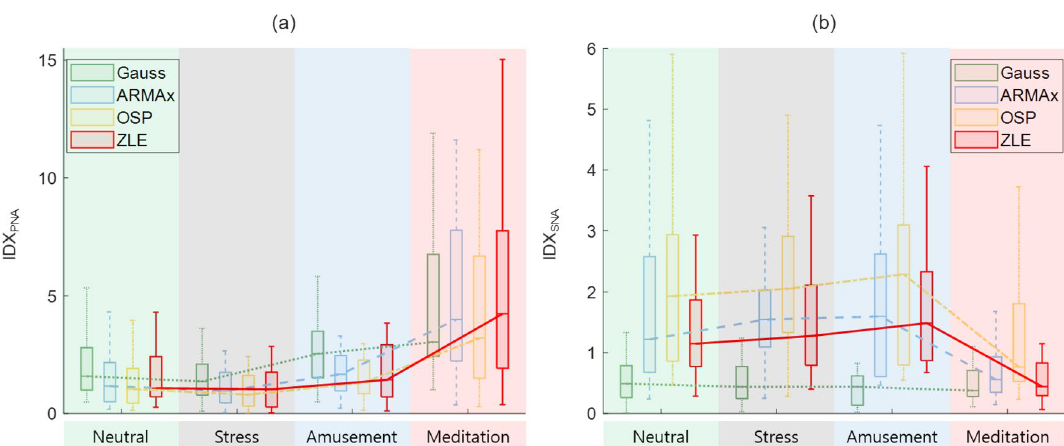
Figure 9. Changes in HRV indices (( a ): IDX PNA and ( b ): IDX SNA ) of tachogram decomposition algorithms according to 4 affective states. Gauss (green boxes and dotted line); ARMAx (blue boxes and dashed line); OSP (yellow boxes and dash-dotted line); ZLE (red boxes and solid